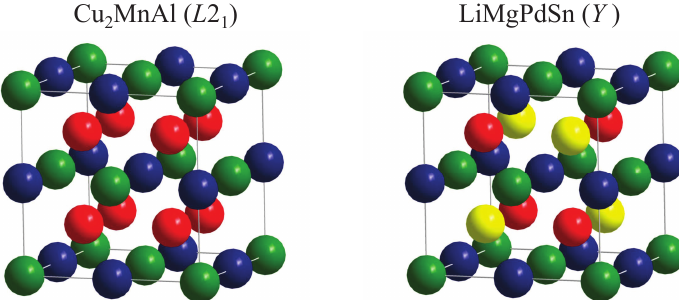
Figure 1. Crystal structures of Heusler compounds with and without centre of inversion. The figure shows sketches of the regular, centrosymmetric Cu 2 MnAl structure with O h symmetry and the quaternary, non-centrosymmetric LiMgPdSb structure with T d point group symmetry. The accompanying space groups are F m 3 m and F 43 m ,